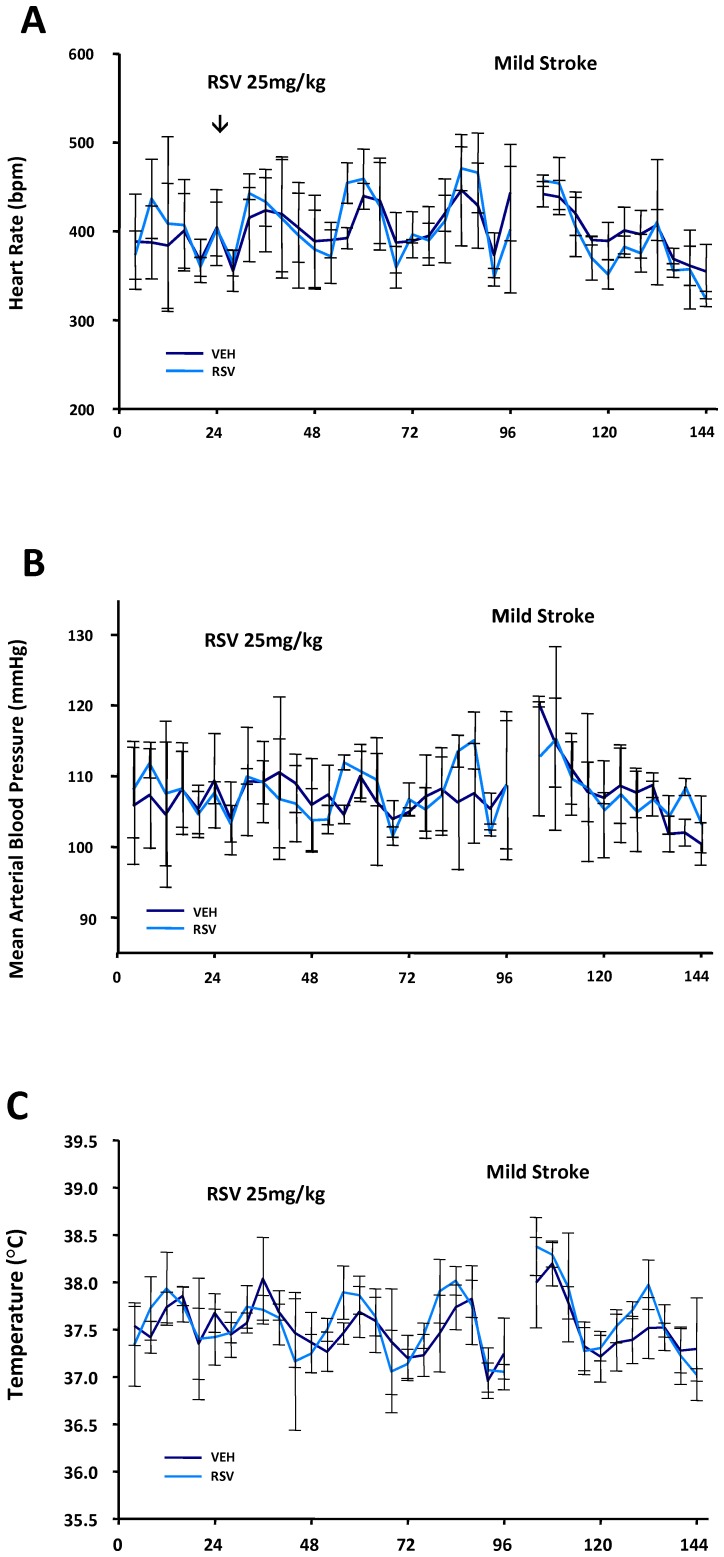
Telemetric measures of heart rate (A), mean arterial blood pressure (B) and body temperature (C).Mean (±SD) values were similar in resveratrol (RSV, 25 mg/kg/day for 4 doses) and vehicle (Veh) treated rats at all times for 24 hr prior to treatment, for 3 days during treatment (prior to a mild stroke) and during the 48 hr of monitoring thereafter.